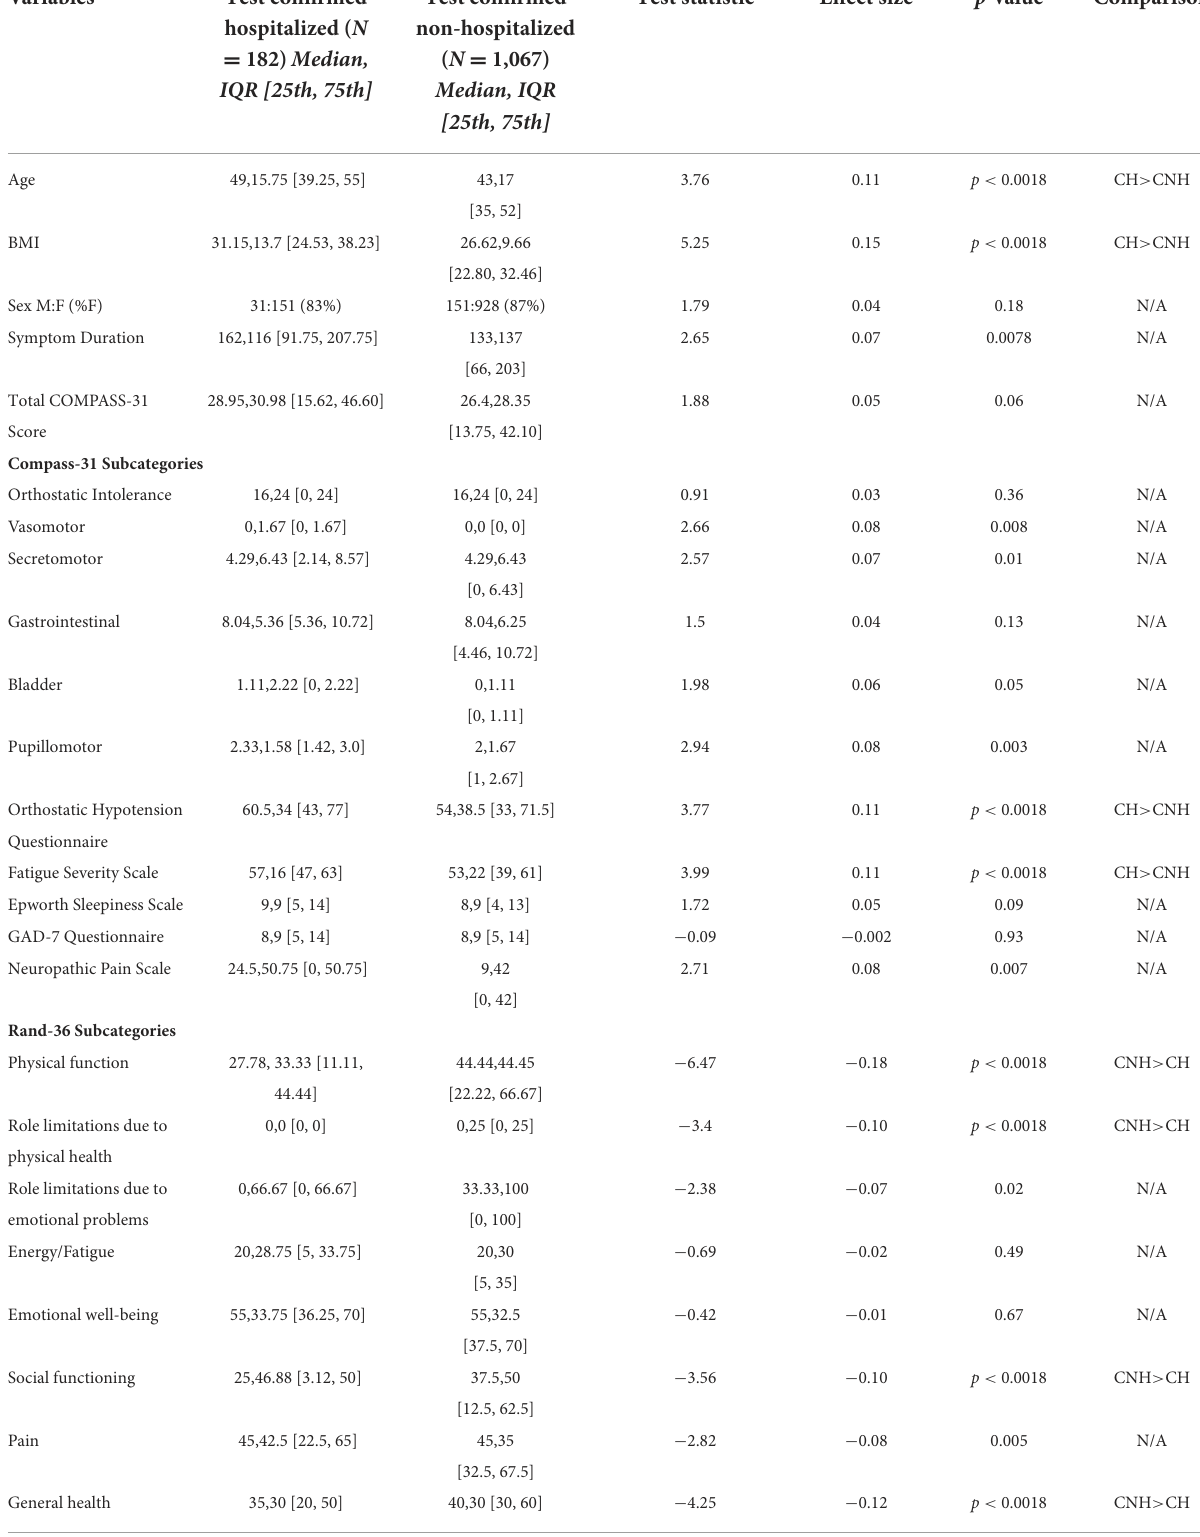
TABLE 5 Comparison of demographic variables and symptoms scores in test-confirmed hospitalized and test-confirmed non-hospitalized participants. Variables Test statistic Effect size p -value